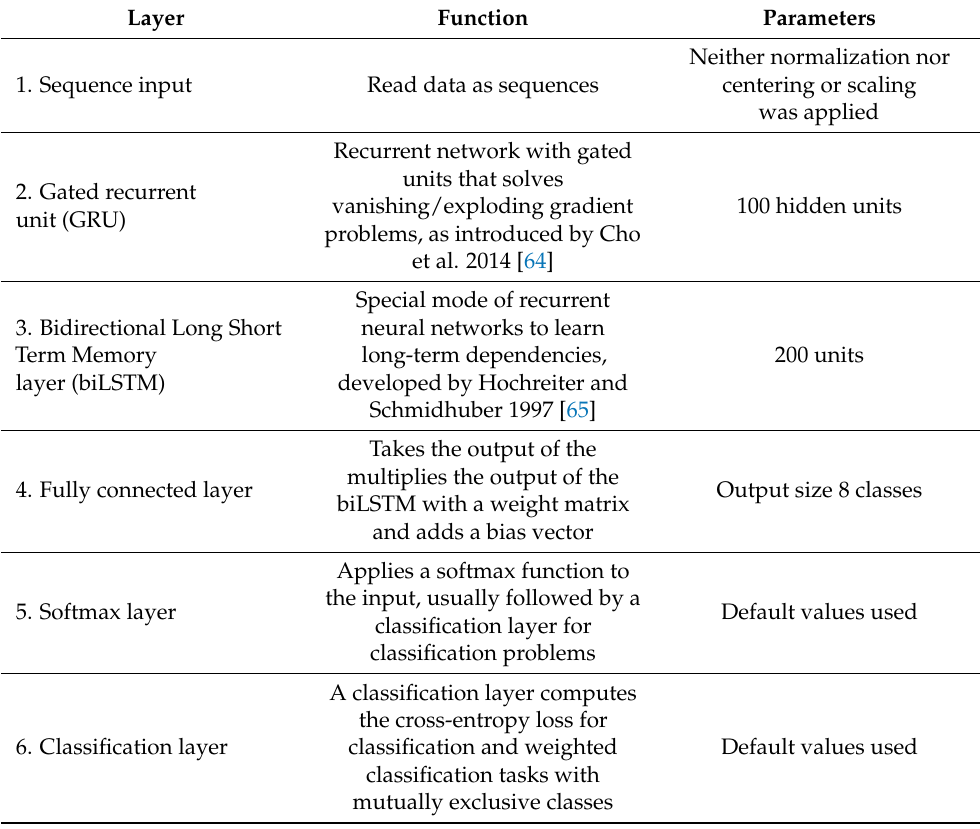
Table 2. The architecture, layers, and parameters of the deep learning model